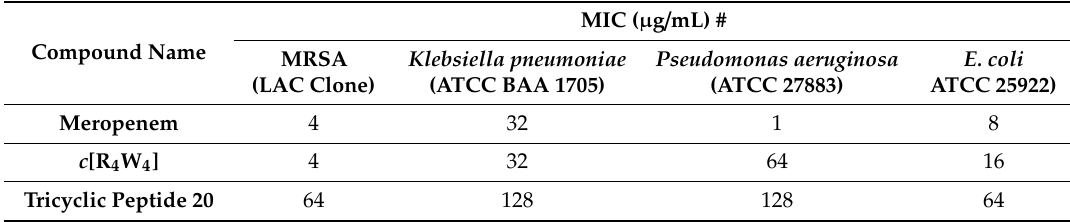
Table 1. Antibacterial activity of Tricyclic peptide 20 .